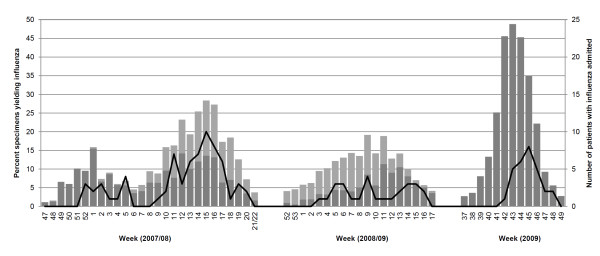
Comparison of influenza activity by laboratory surveillance in Ontario. Data are expressed as the percentage of specimens submitted to reference virology laboratories yielding influenza, 2007/08 and 2008/09 influenza seasons and second wave of the 2009 H1N1 influenza pandemic (light grey bars: influenza B; dark grey bars: influenza A), as well as the corresponding number of patients admitted to participating ICUs with influenza (black line).